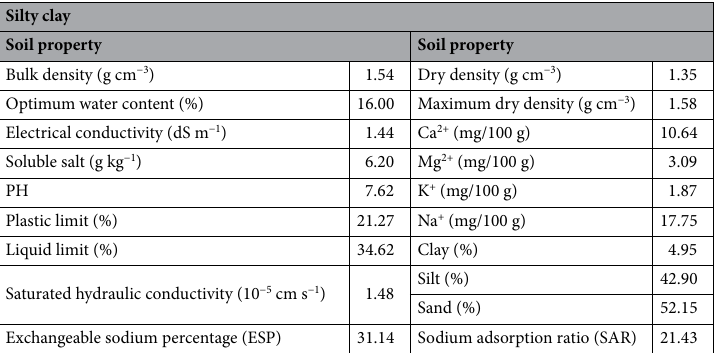
Table 1. Basic physicochemical properties of the saline–alkali soils used in this study.